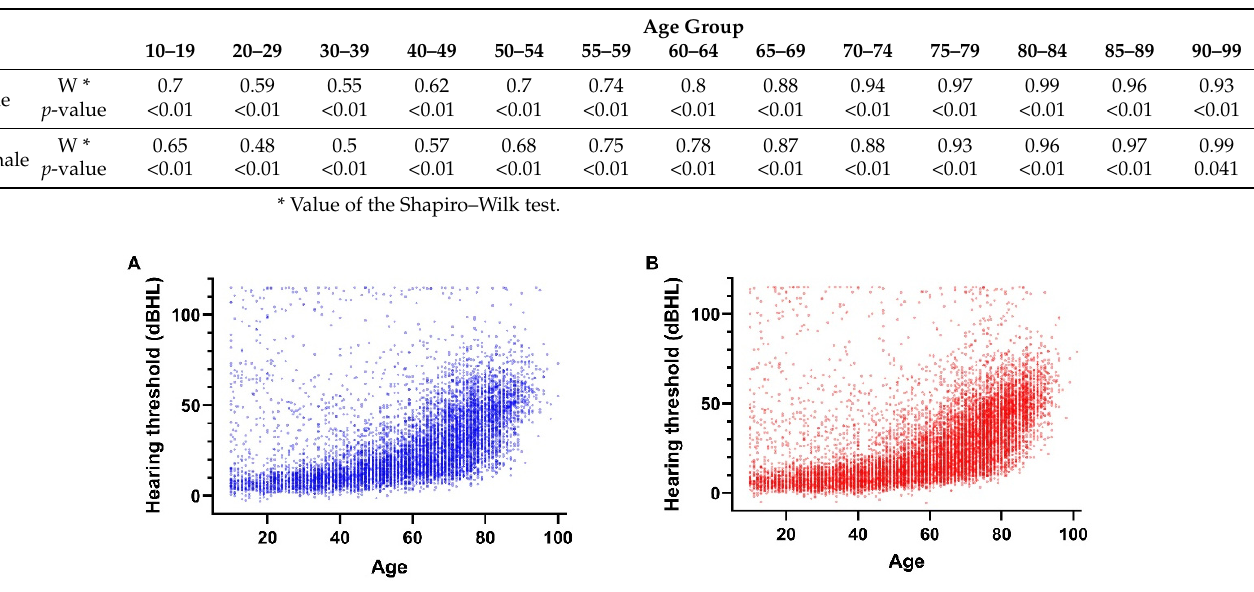
Figure 2. Gender- and age-specific scatter plots of mean hearing thresholds (N = 23860). ( A ) Males (N = 9078). ( B ) Females (N = 14782). Average of left- and right-side hearing thresholds was calculated for each subject at 500, 1000, 2000, and 4000 Hz, and then the simple arithmetic mean over the four frequencies for each subject was calculated and plotted. Some subjects’ mean threshold exceeded the ceiling dBHL of 110 dBHL, in which case they were assigned a dBHL value of 115.